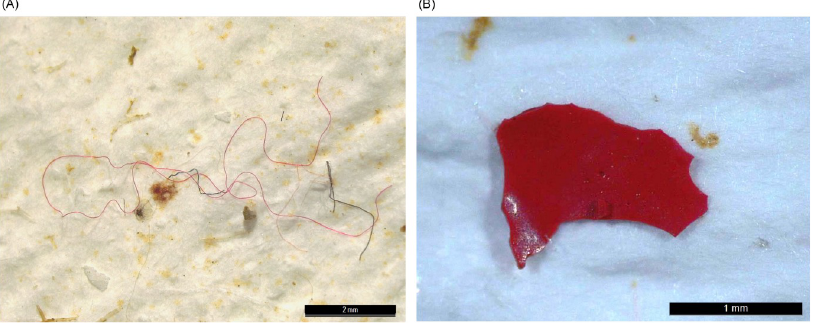
Fig 3. Pictures illustrating the typical appearance of the microplastic particles found. (A) An agglomeration of fibres, typically found on the samples; (B) A red microplastic fragment, showing characteristics for microplastic identification such as irregular edges and bright